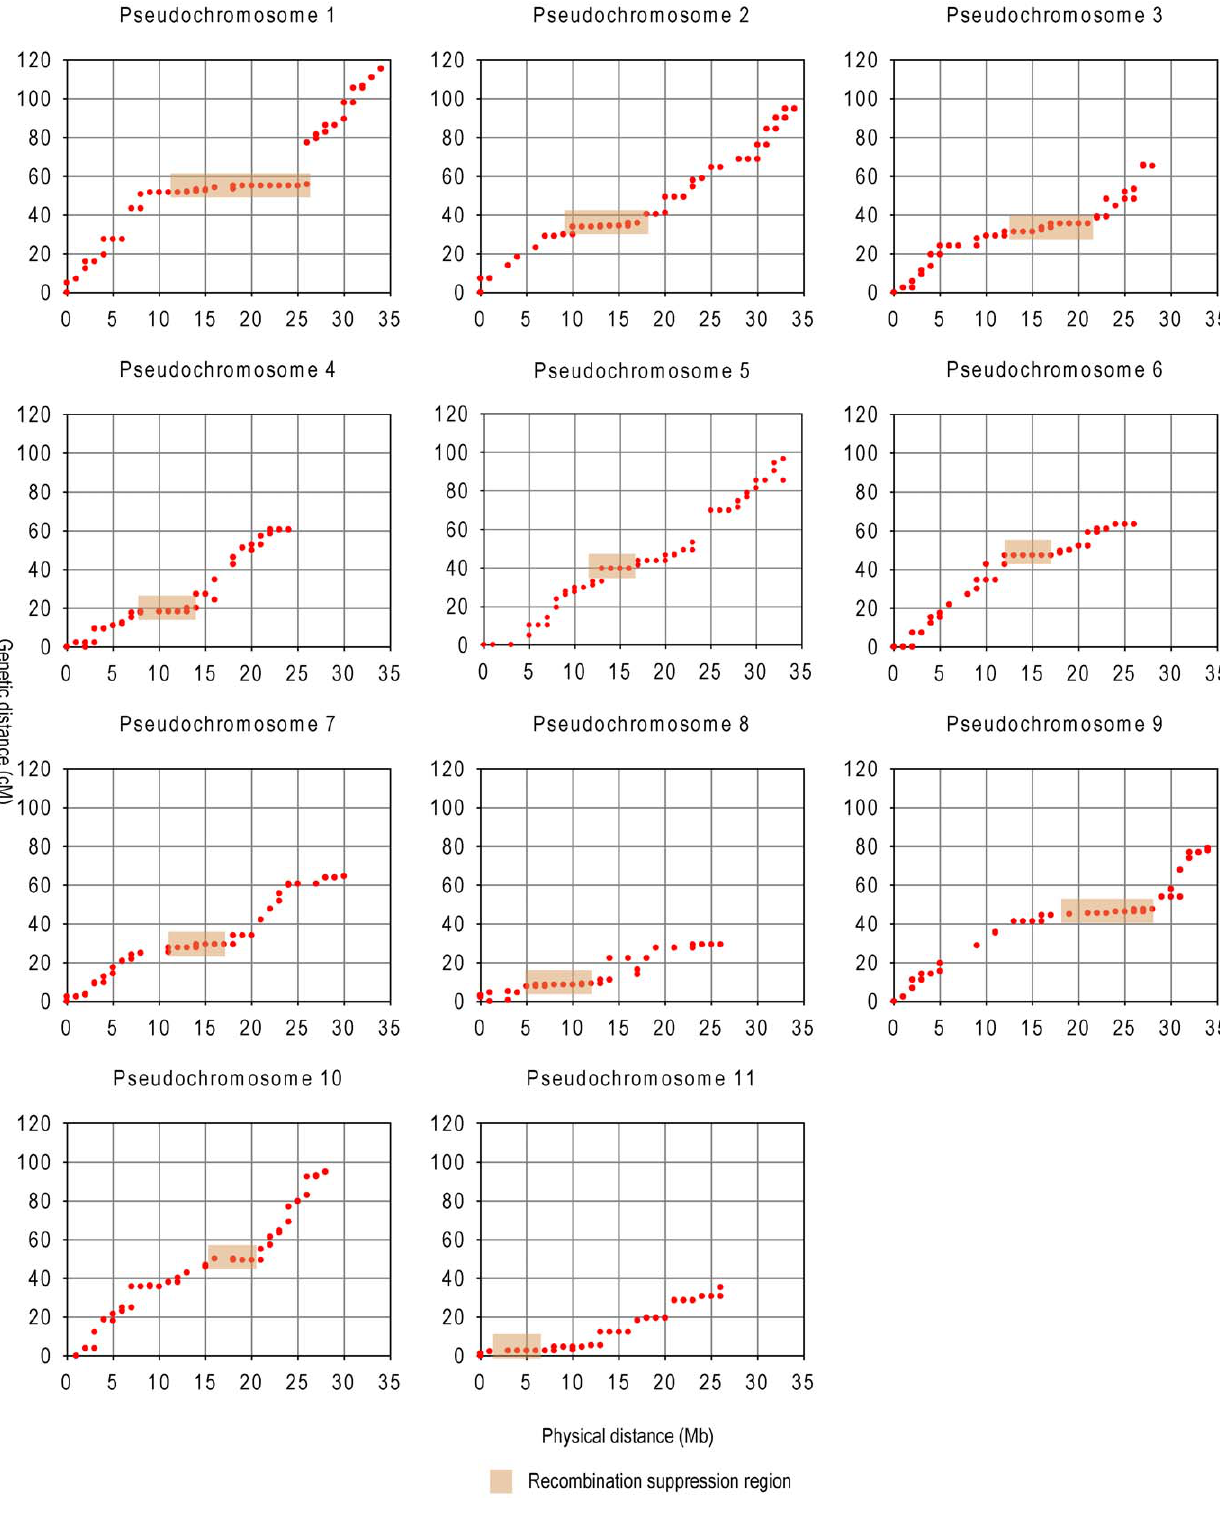
Figure4. Plots ofgeneticvsphysicaldistance for eachlinkagegroup. Ineachplot,physicaldistance isonthe horizontalaxis(in Mb),and genetic distance is on the vertical axis (in cM). The recombination suppression regions (nearly flat in shadow) are predicted to be pericentromeric regions.